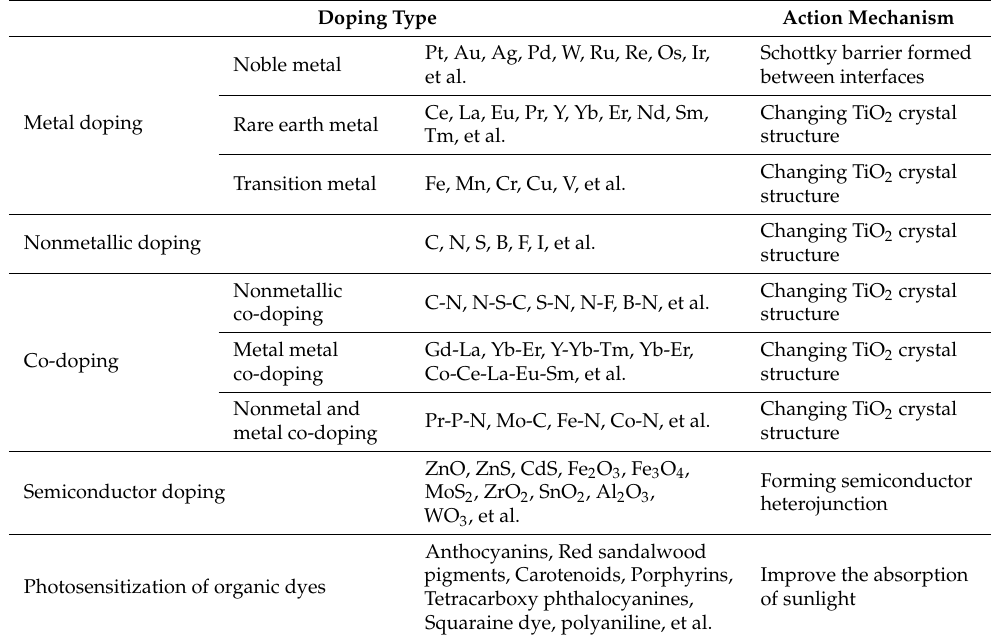
Table 2. Summary of TiO 2 modification